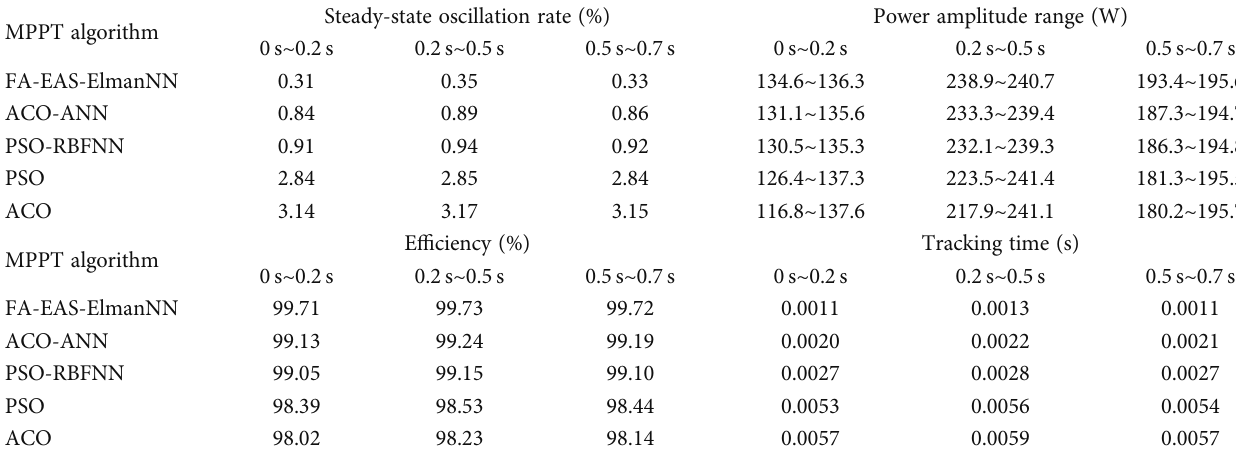
Table 1: The results of fi ve MPPT